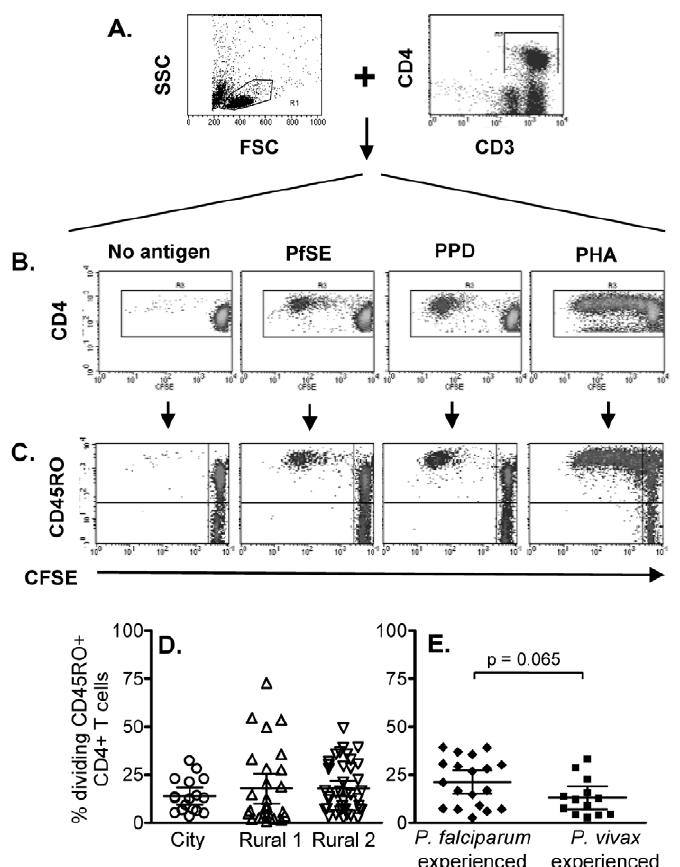
Figure 1. Flow cytometric characterization, frequencies and longevity of memory CD4 T cells proliferating in response to PfSE. CFSE-labeled PBMCs were stimulated with no antigen, PfSE, PPD or PHA for 6 days. Cells were harvested and stained with fluorochrome-conjugated anti-CD3, CD4 or CD45RO mAbs. (A) PBMC were gated by forward and side scatter and the CD3 + and CD4 + T lymphocyte population was identified; (B) CFSE expression in CD4 + T cells. CD3 + CD4 + T cells were gated and CFSE expression examined in relation to CD45RO (C) expression. The plots demonstrate the results for one representative subject known to have been infected previously by P. falciparum . Percentages of proliferating CD45RO + CD4 + T cells (CFSE low ) among (D) city (circles), Rural 1 (triangles) and Rural 2 (reverse triangles) subjects and (E) between individuals who had been infected with P. falciparum and P. vivax . Mean 6 95% confidence interval is shown for each group.